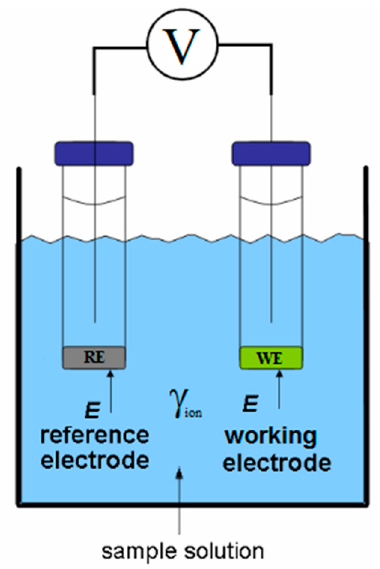
Figure 2 . Setup of the potentiometric biosensing measurement . Figure 2. Setup of the potentiometric biosensing